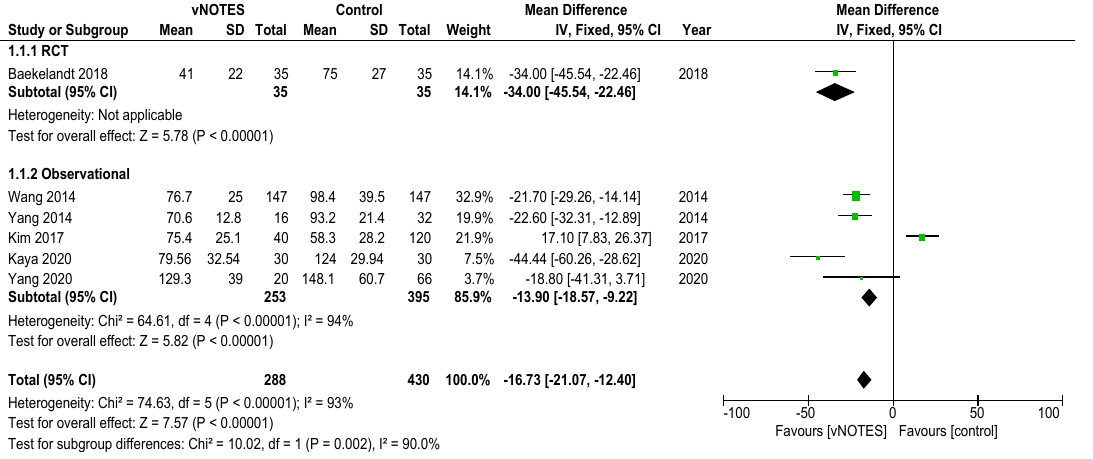
Figure 2. Forest plot of comparison vNOTES versus control, outcome: operation time.